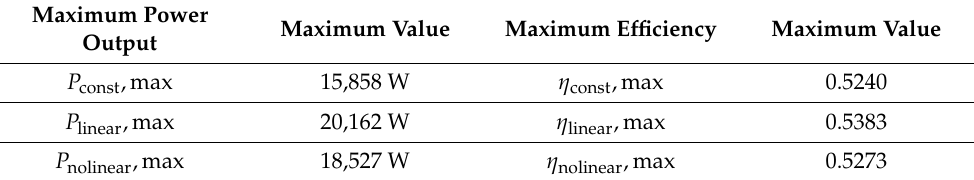
Table 2. Maximum values of P and η of the three cycle